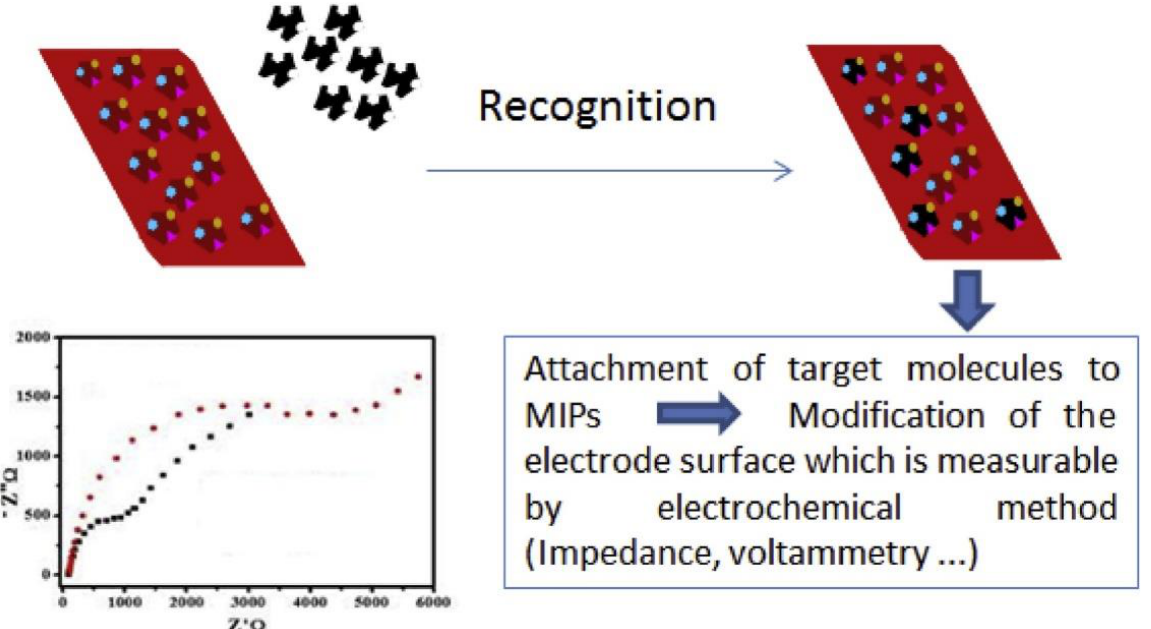
Figure 2. The principle of MIP-based electrochemical sensors. Adapted with permission from Ref. Ref. [58]. Copyright 2020,